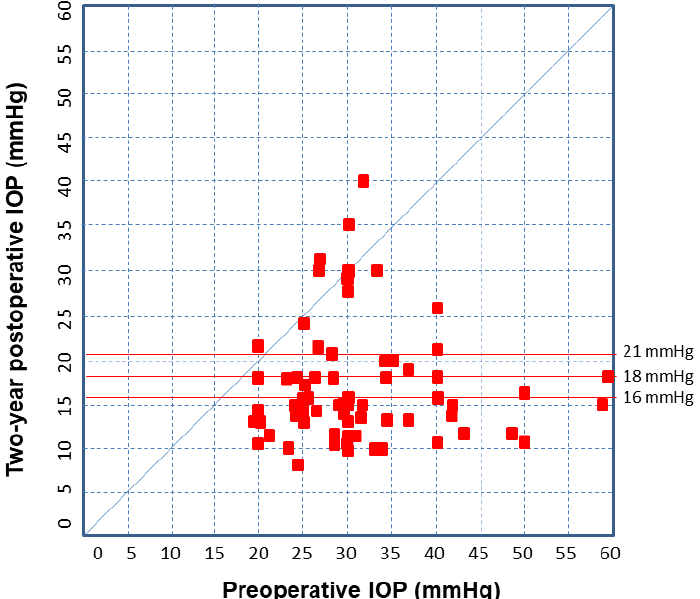
Figure 2. Scatter plot of IOP values before surgery and after canaloplasty in 67 PEXG eyes after 2 years. The qualified and complete success rates based on the three different IOP cut-offs after 2, 3 and 4 years are reported in Table 1; Table 2.